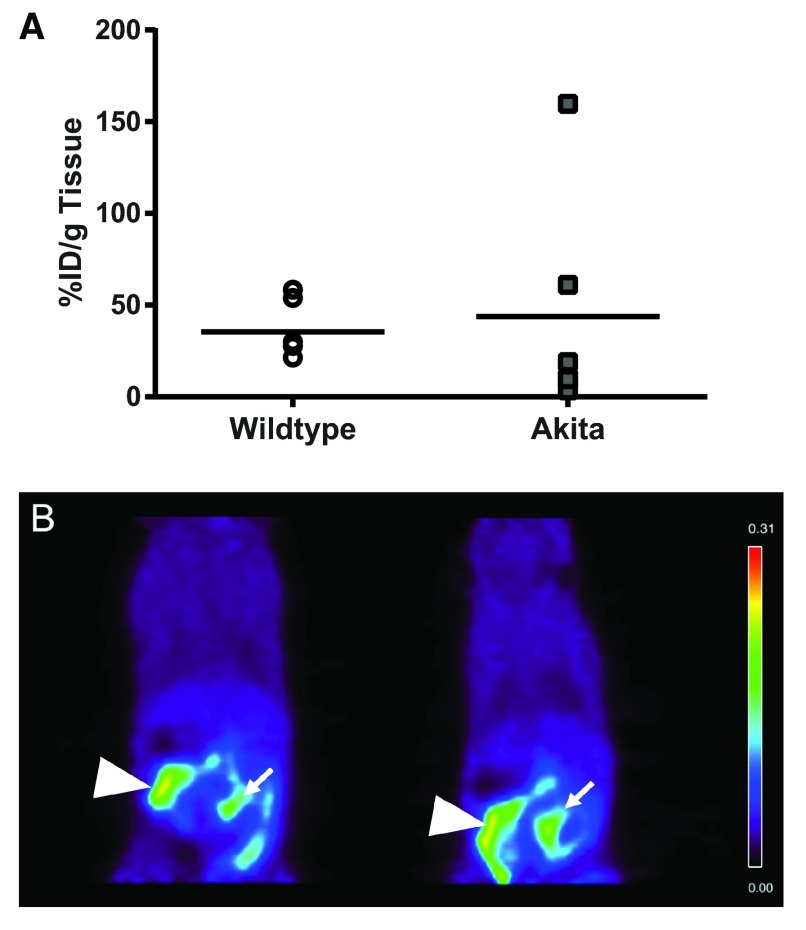
Pancreas-specific uptake of
18F-L-FEHTP in wt and Akita mice.
a)
Ex vivo tracer uptake was calculated for the pancreas of wt (n=6) and Akita (n=6) mice as % ID/g tissue at 1.5 h after injection.
b) PET imaging of the pancreas after injection of
18F-L-FEHTP. One hour after injection, static images were acquired for 30 min. Representative images of wt (n=6) and Akita (n=5) mice show highly specific uptake in the pancreas with little detectable background uptake. Arrowheads indicate position of the pancreas. Arrows indicate position of spleen.